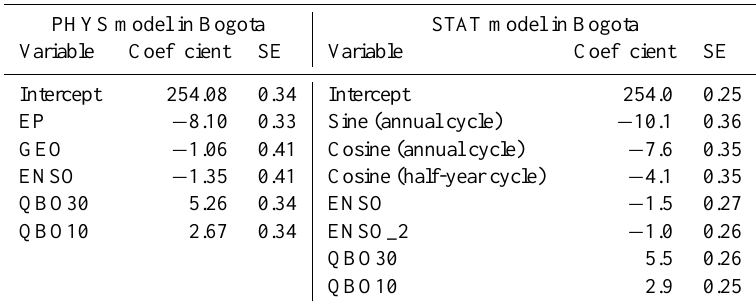
Table 5. Regression coefficients and standard errors of regressions in Bogota, Colombia. QBO10 and QBO30 represent the QBO index at 10 and at 30hPa, respectively.